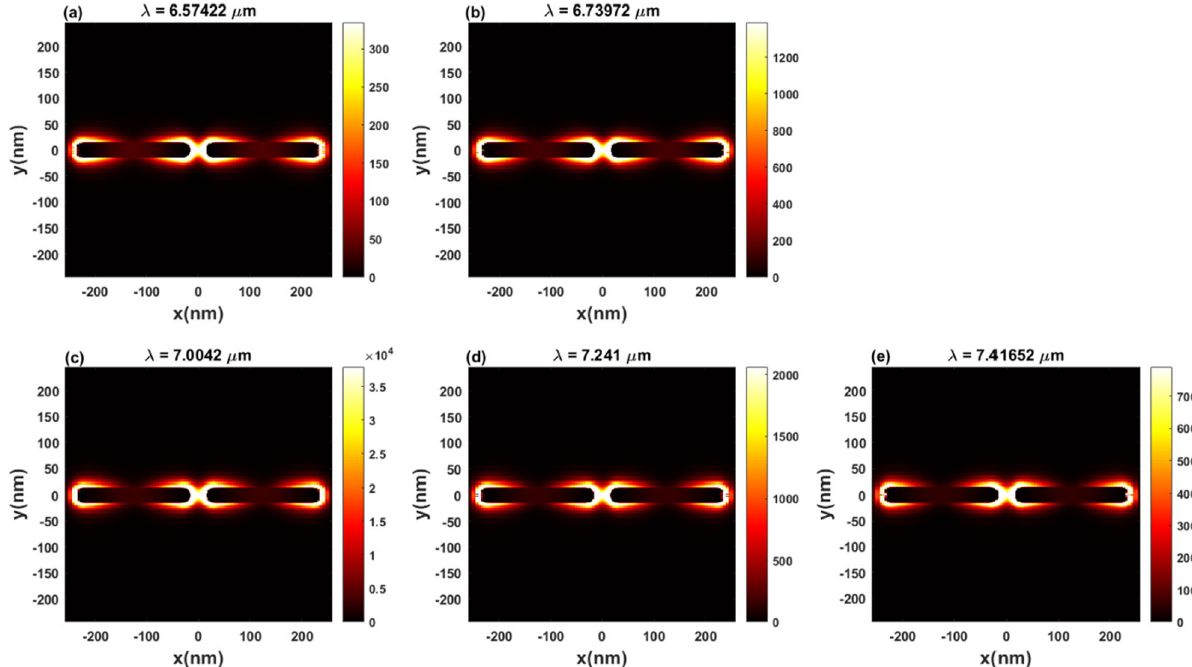
Figure 6. The distribution of the local electric field in the XZ -plane induced by normal incidence at the resonant